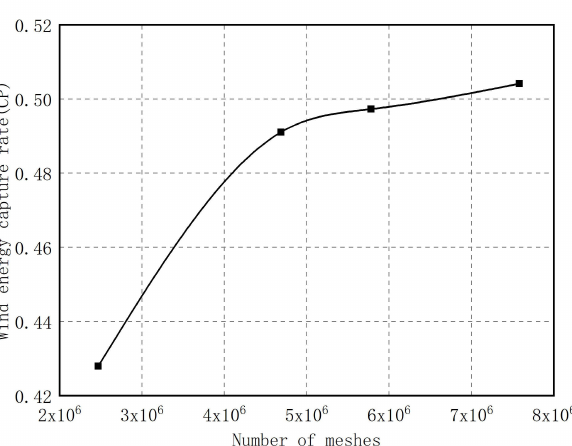
Figure 10. Curve of wind energy capture rate changing with the number of